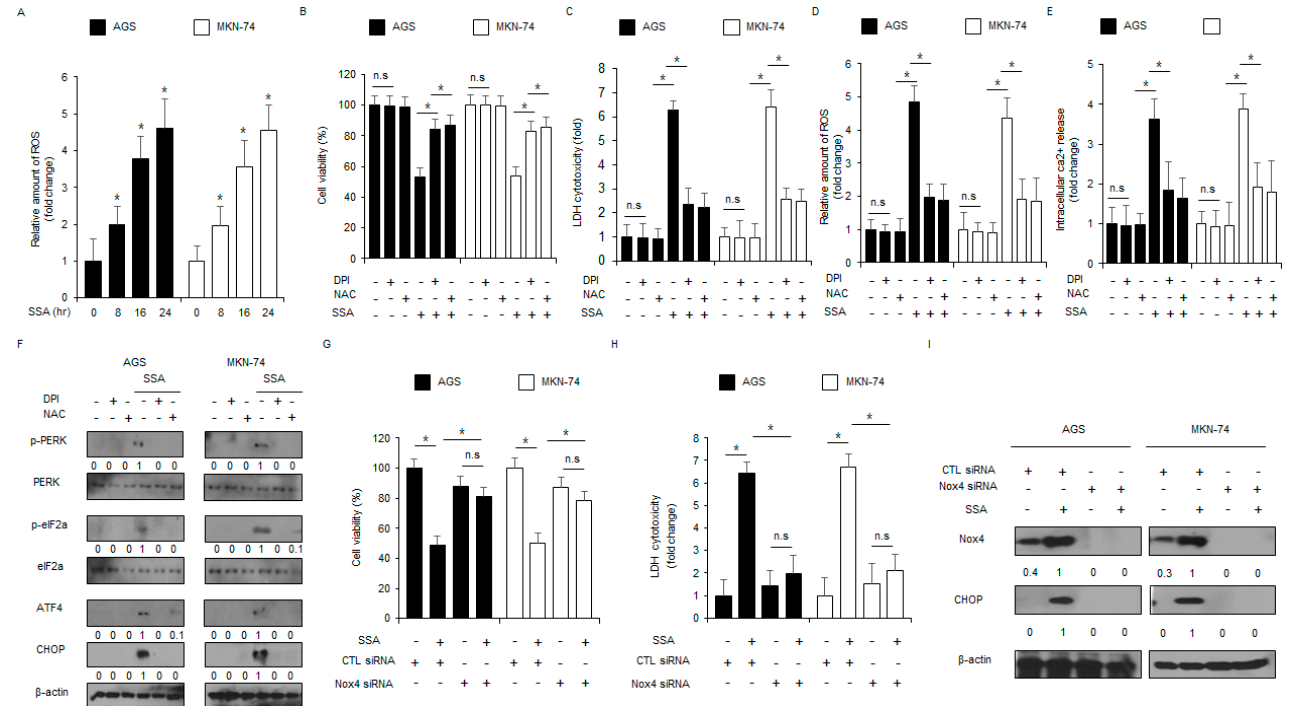
Figure 5. Nox4 regulates ER stress and cell death in SSA-treated GC cells. ( A ) AGS and MKN-74 cells were treated with SSA (10 µ M) for the indicated times, and the cells were stained with DCFDA (20 µ M) and analyzed with a microplate reader. ( B – F ) AGS and MKN-74 cells were pre-treated with NAC (10 mM) and DPI (10 µ M) for four hours and then treated with SSA (10 µ M) for 24 h. Cell viability, cell cytotoxicity, ROS release, and Ca 2+ release were determined using WST-1, LDH, intracellular ROS, and intracellular Ca 2+ assays; *, p < 0.05. ER stress markers (p-PERK, PERK, p-eIF2 α , eIF2 α , ATF4, and CHOP) were determined by Western blot assay. β -actin was used as a protein loading control. ( G – I ) After AGS and MKN-74 cells were transfected with Nox4 siRNA, they were treated with SSA (10 µ M, 24 h), and cell viability, cytotoxicity, and Nox4 and CHOP levels were determined; *, p < 0.05. β -actin was used as a protein loading